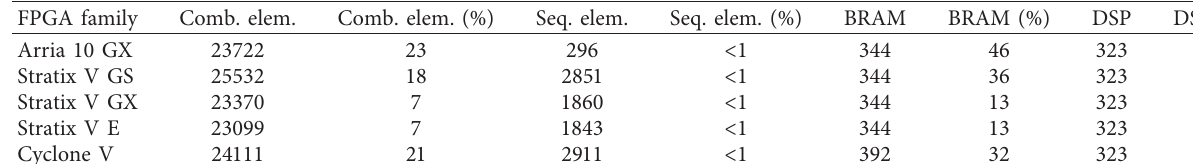
Table 6: Hardware accelerator implementation on Intel FPGAs.